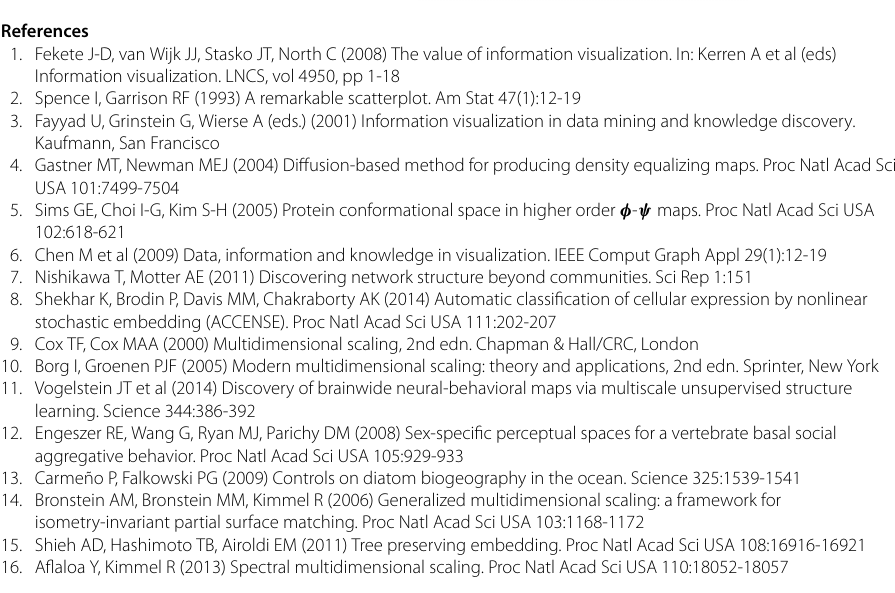
- Apply Table  formulae to compute δ ( x ) - Use similarly modified formulas to compute δ ( y )